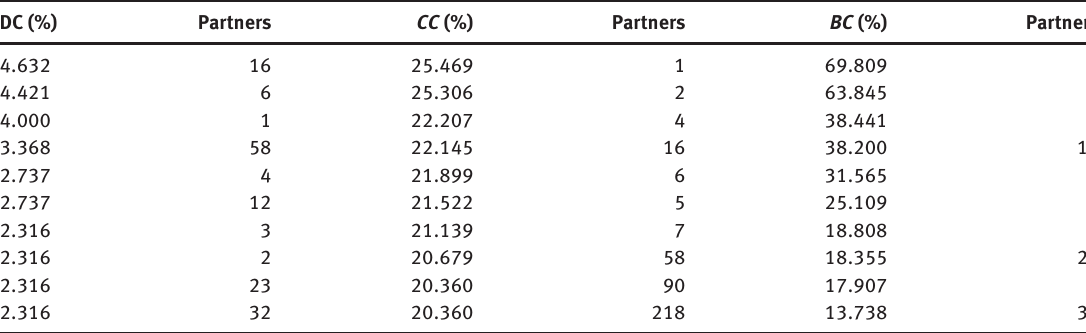
Table 2. Partners Selected by Three Centricity Measure Indices.